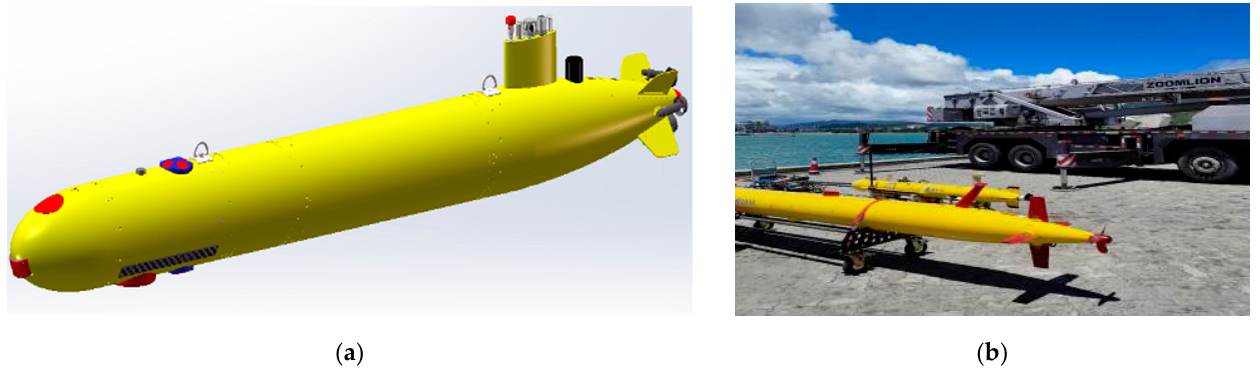
Figure 1. Diagram of the real-time AUV-based SSS underwater-target detection system.